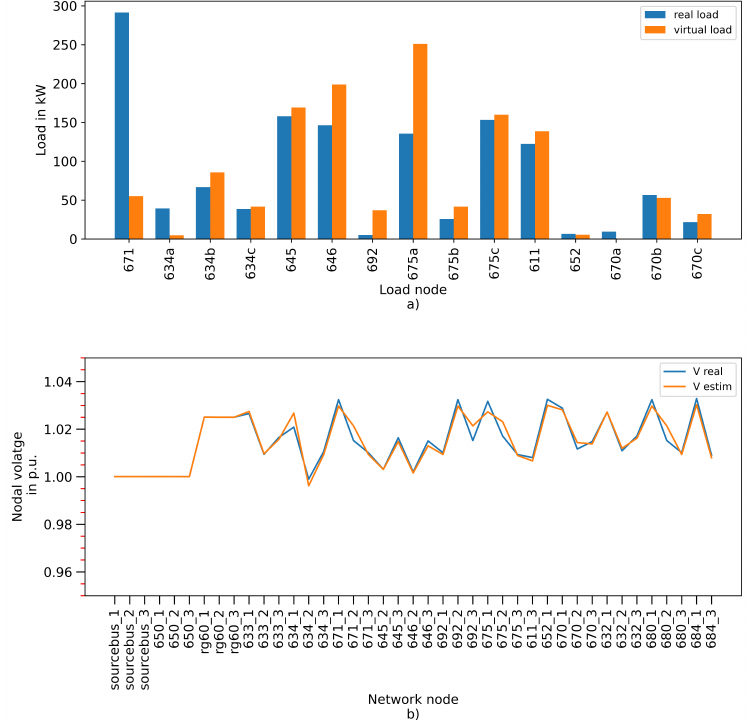
Figure 6. ( a ) Different load combinations resulting in ( b ) close voltage profiles. Example for IEEE 13 node test